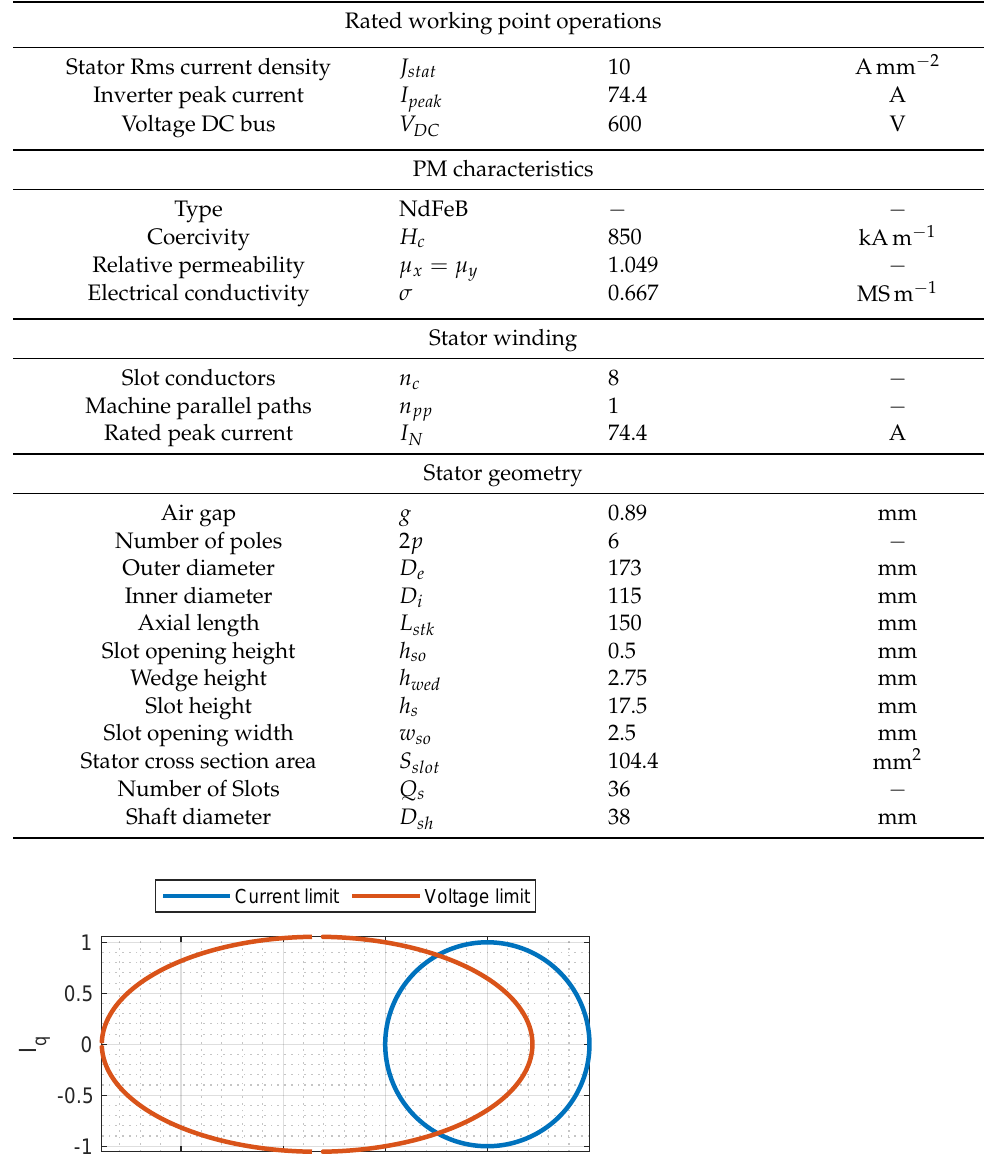
Table 1. Characteristic shared by all machines.